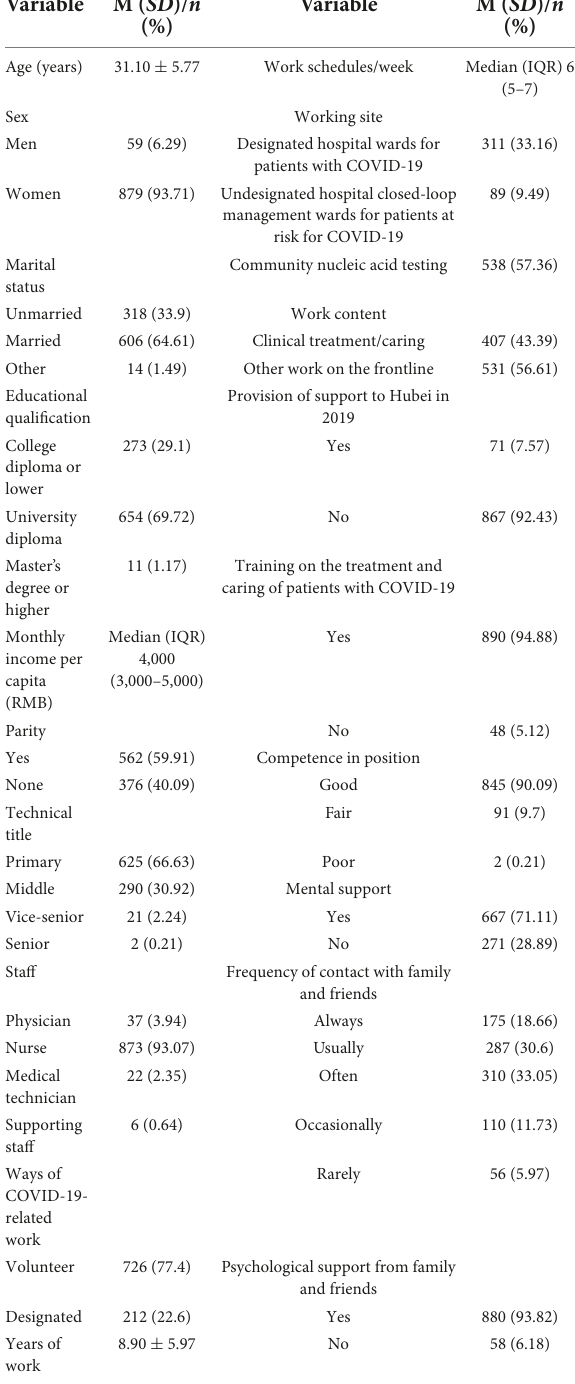
TABLE 1 Sociodemographic information of participants ( n = 938) and study